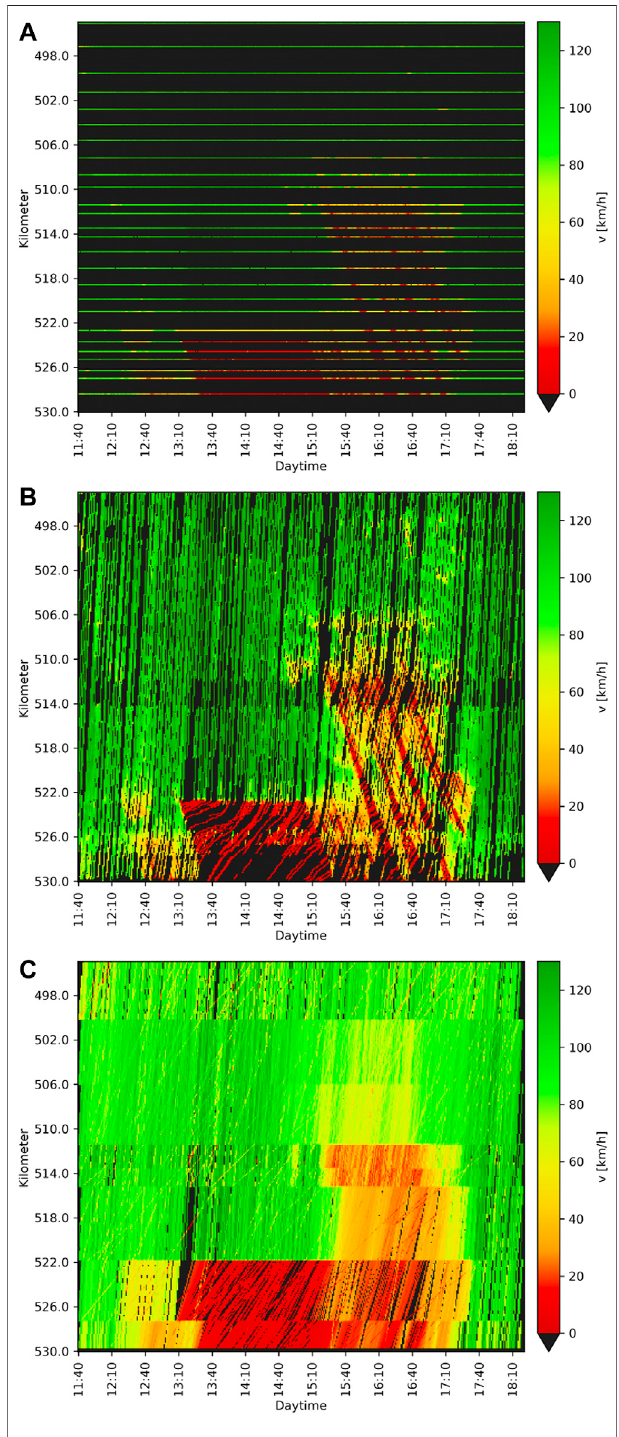
FIGURE 2 | Raw speed data measurements provided by (A) loop detectors, (B) equipped vehicles and (C) Bluetooth receivers.